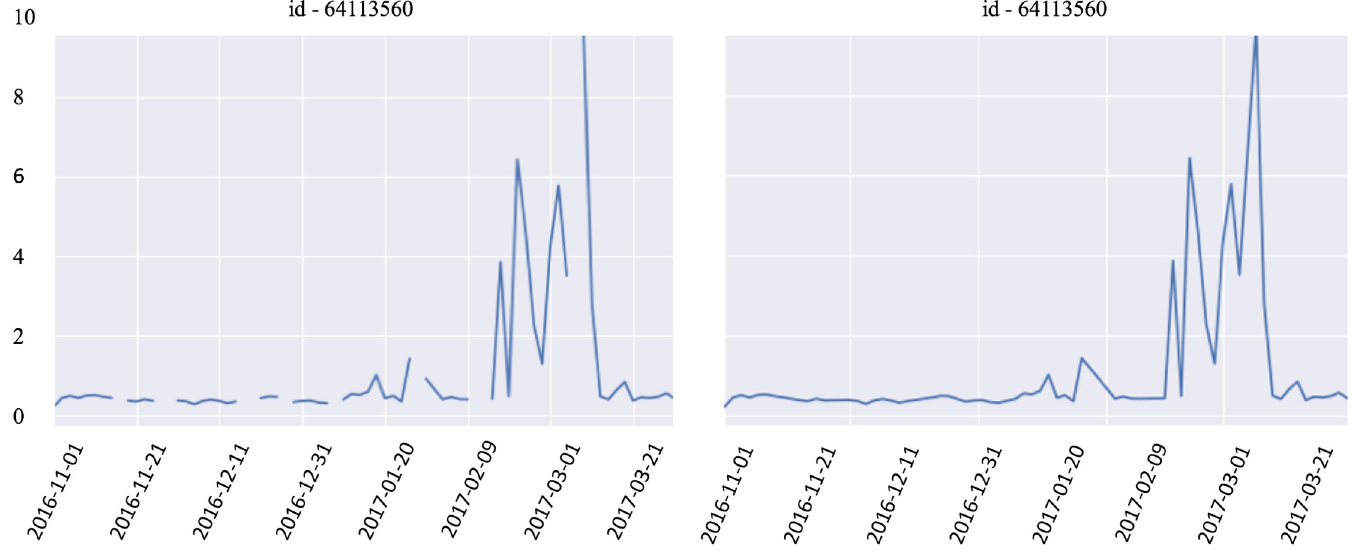
Fig 5. The interpolated time series of ‘ chlor_a’ from the float id 64113560 on the left is shown on the right.